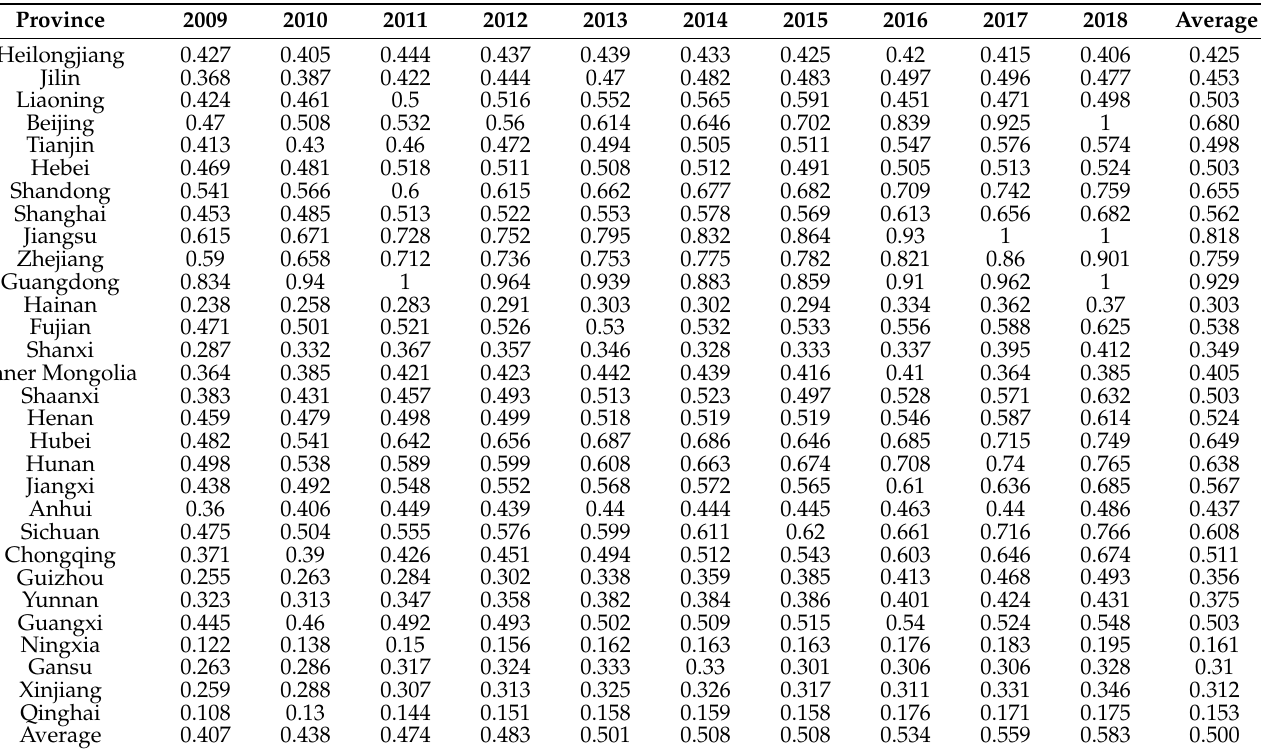
Table 5. The comprehensive carbon emission efficiency during China’s third stage (2009–2018).